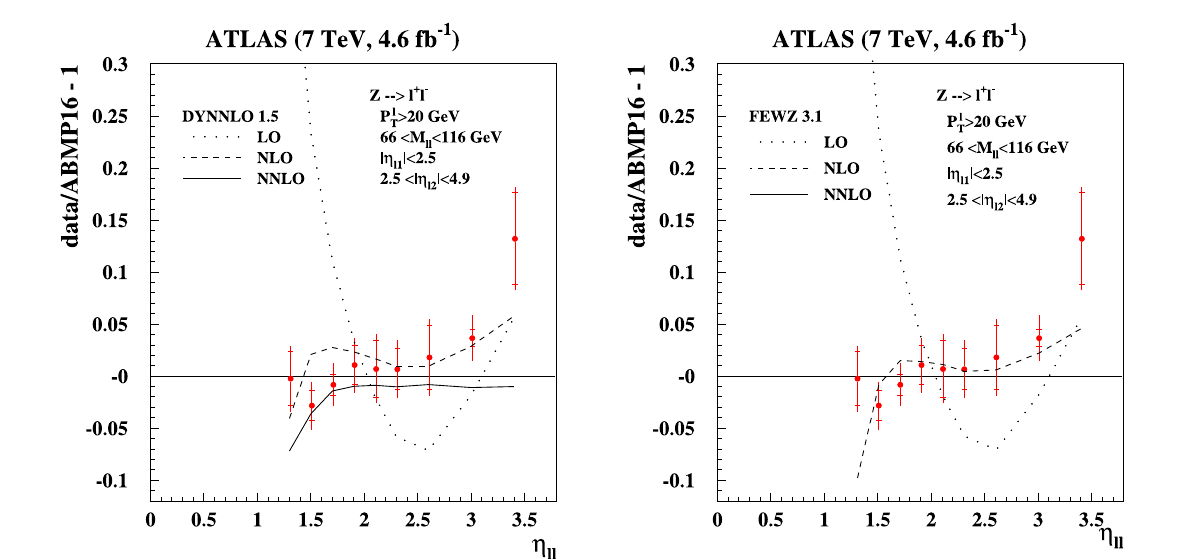
Fig. 9 ThepullsfortheATLASdatafor pp → Z /γ ∗ + X → l + l − + X 3.1) compared to predictions by the DYNNLO (left) and the FEWZ codes √ s = 7 TeV [6], normal- production at forward rapidities measured at (right). Shown are the LO (dotted), NLO (dashed) and NNLO (solid) predictions for each code ized to the ABMP16 predictions at NNLO obtained with FEWZ (version